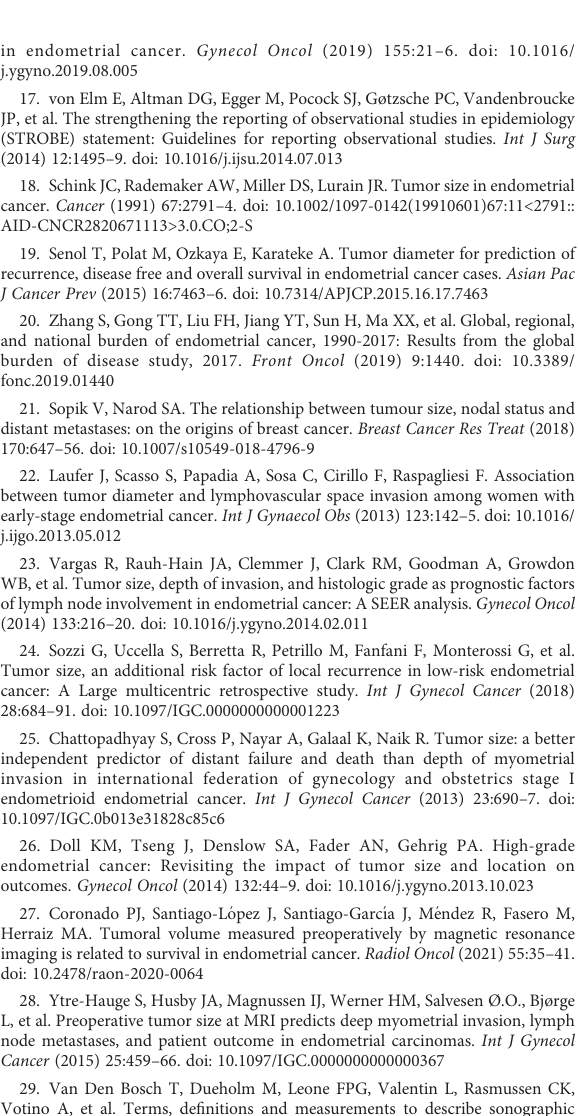
Kaplan – Meier survival estimates of time to death from cancer, for prognostic group (stage, grade, age, BMI, stage, grade, LVSI, myometrial invasion, lymph node involvement, histotype, adjuvant treatment) and by 4 cm tumor diameter cut-off. SUPPLEMENTARY FIGURE 9 Kaplan – Meier survival estimates of time to disease relapse, for prognostic group (stage, grade, age, BMI, stage, grade, LVSI, myometrial invasion, lymph node involvement, histotype, adjuvant treatment) and by 4 cm tumor diameter